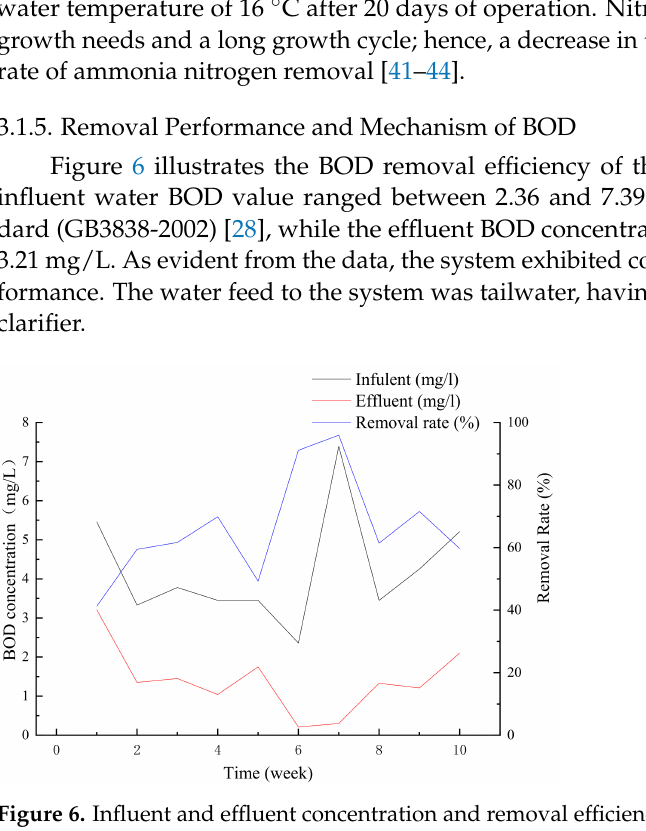
Figure 6. Influent and effluent concentration and removal efficiency of